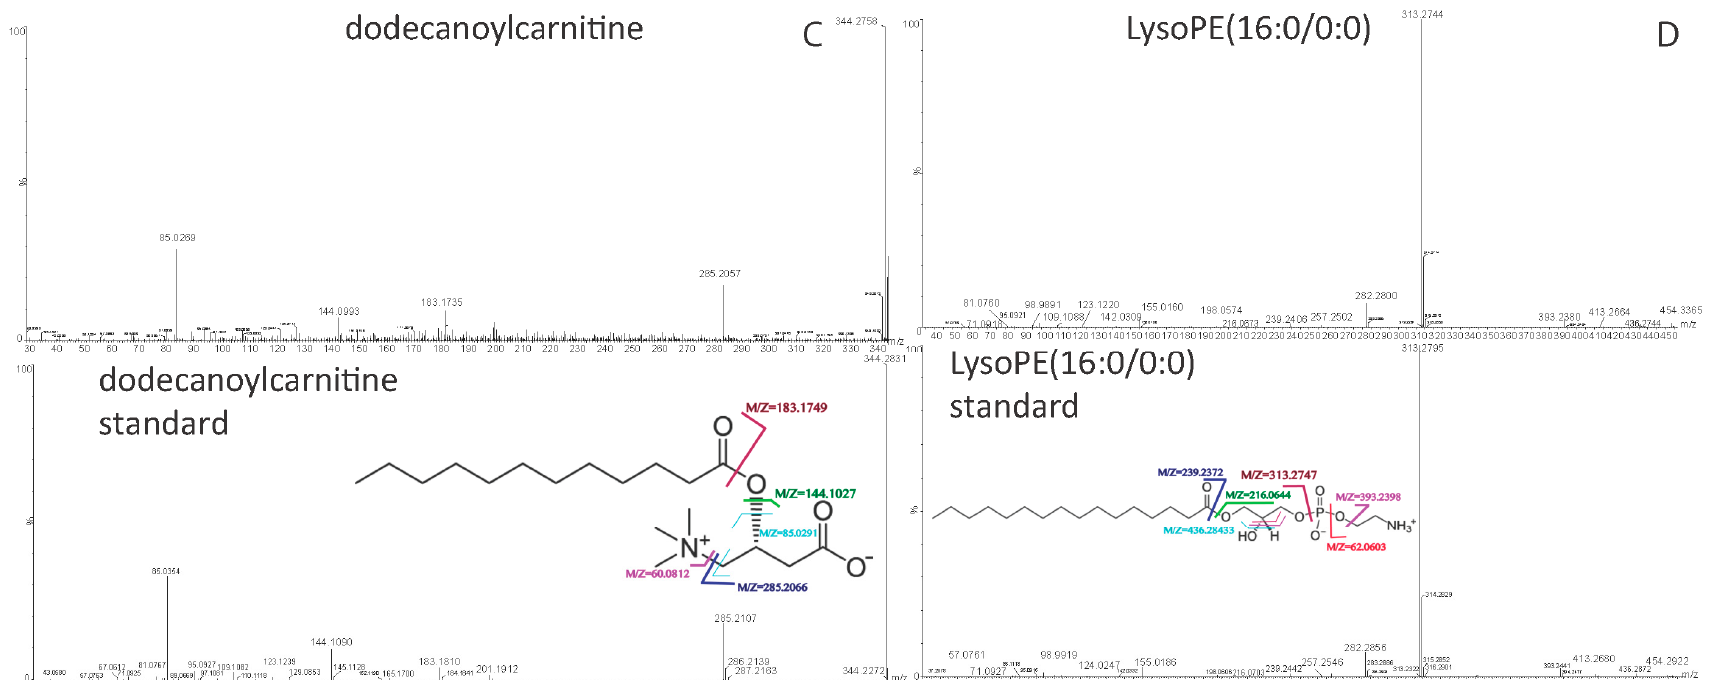
Figure 3. Cont. Figure 3.